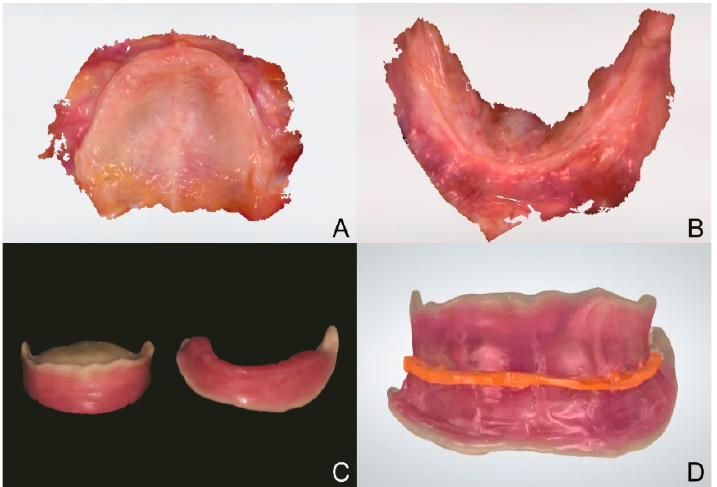
Figure 1. Impression making and bite registration for edentulous arches. ( A ) Digital intraoral scan data of a maxillary arch. ( B ) Digital intraoral scan data of a mandibular arch. ( C ) Trial denture base and wax rim assemblies. ( D ) Scan data of the united assembly with registered interarch relationship.